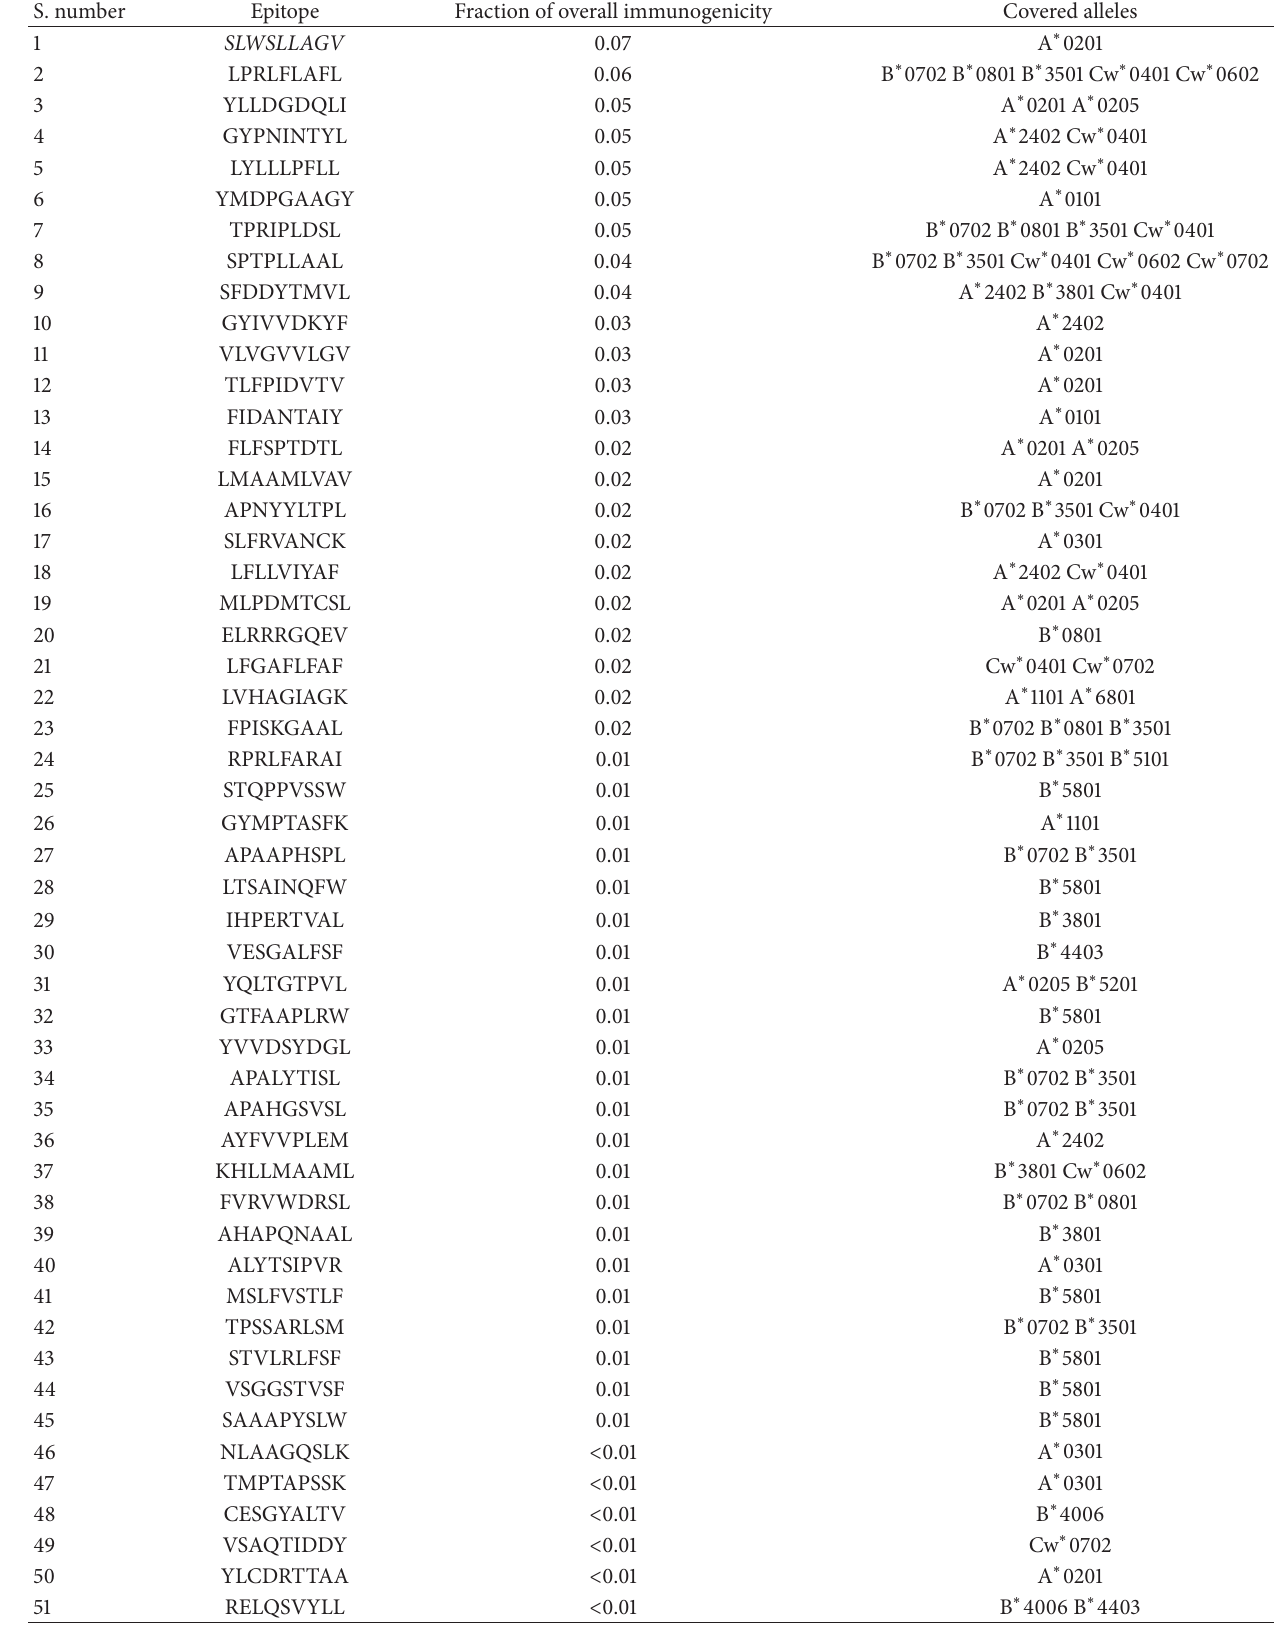
Table 4: The distribution of fractional immunogenicity for the 60 optimal epitopes against the population of Southwest Asia. S.